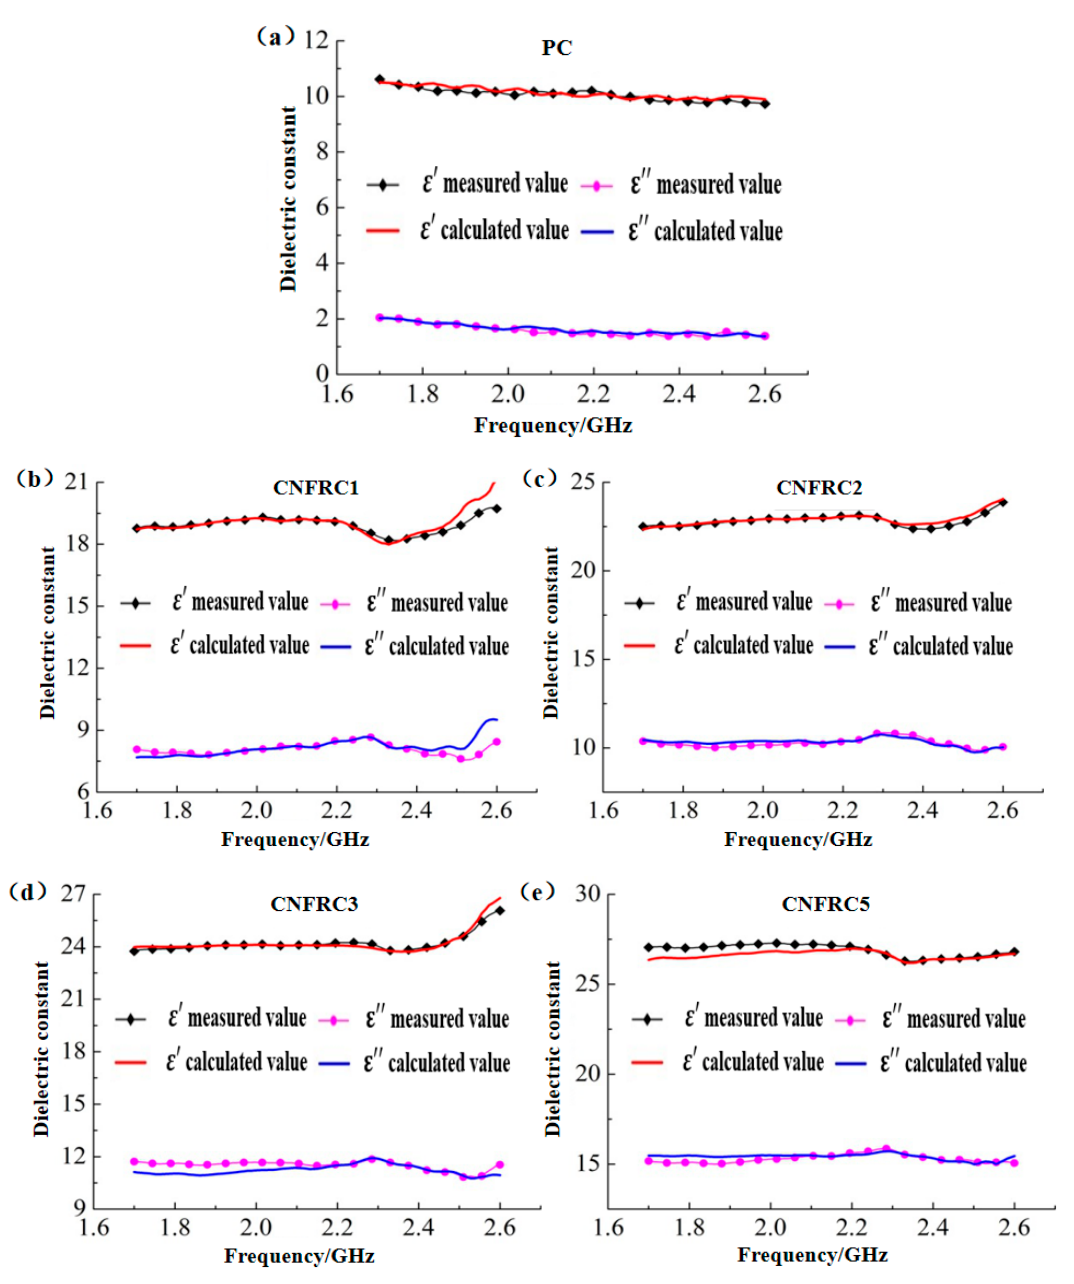
Figure 16. Verification of the measured values with the calculated values based on modified Brown model for groups of specimens. ( a ) PC; ( b ) CNFRC1; ( c ) CNFRC2; ( d ) CNFRC3; ( e ) CNFRC5.